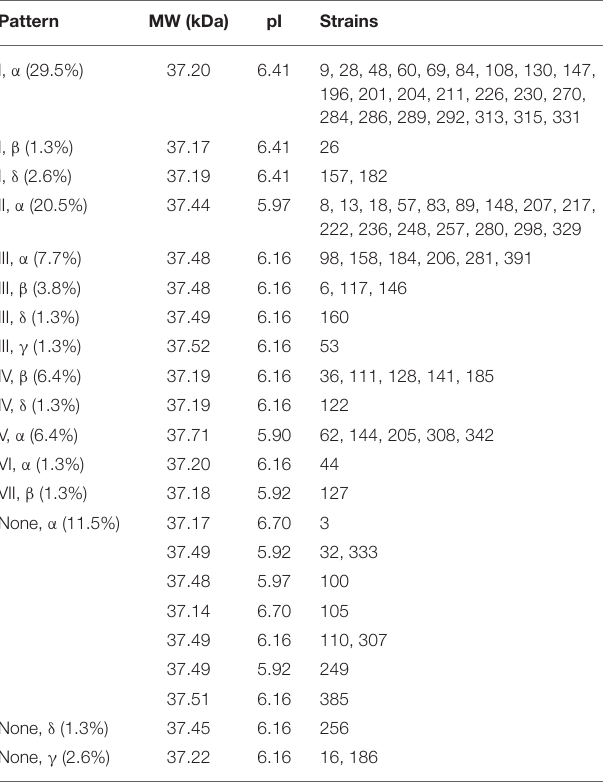
TABLE 3 | (C) Outer loop/linker/dimerization domain patterns and the associated molecular weight and pI predicted by Protein Calculator 3.4. Pattern MW (kDa) pI Strains